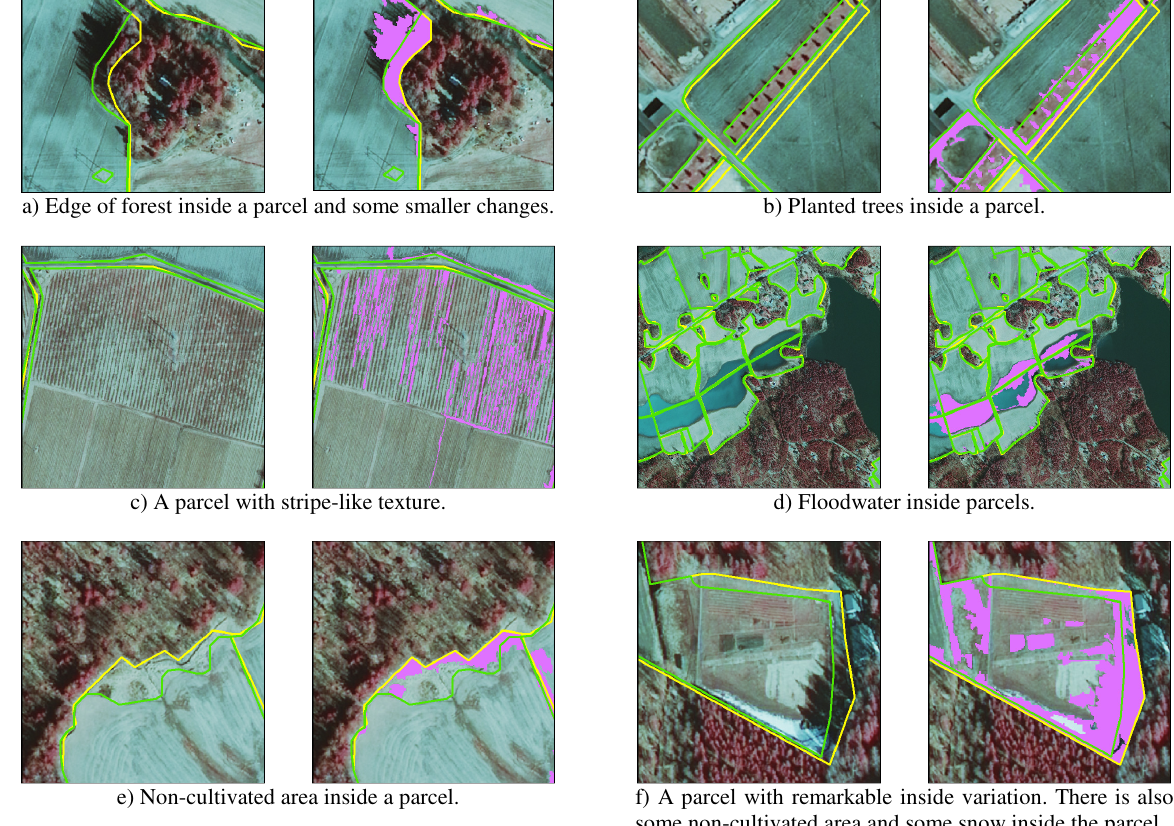
Figure 1. Examples of detected changes, missing changes and false alarms. In each image pair, the left picture shows the false colour aerial ortho image, existing parcel boundaries in the old version of the FLPIS database (yellow lines), and desired boundaries according to reference data (green lines). The right picture shows automatically detected changes (violet areas). Aerial ortho images, copyright © National Land Survey of Finland, 2010. Parcel boundaries, copyright © Agency for Rural Affairs.